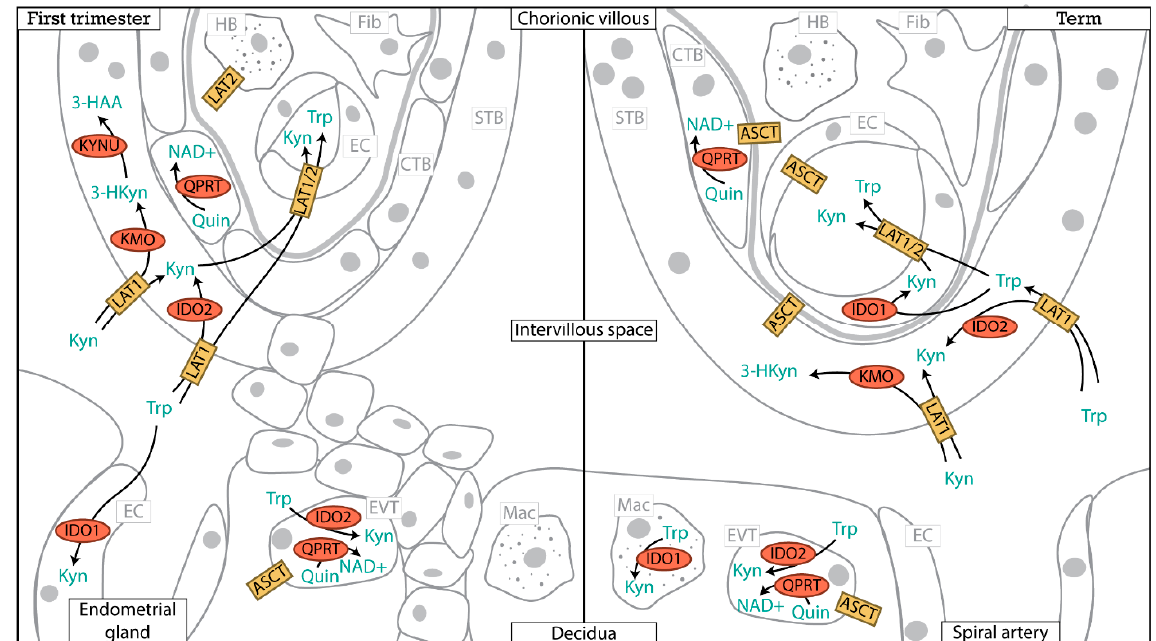
Figure 4. Illustration of kynurenine pathway enzymes and transporters localization in the first trimester and term placenta. This figure only shows the expression of enzymes (red) and transporters (yellow) confirmed by single cell RNA sequencing and/or immunohistochemistry data. The directions and interactions are a hypothetical display of the placental kynurenine pathway. How kynurenine pathway metabolites are exchanged between these cells, and whether this is facilitated by these, or other yet unidentified transporters is currently unknown. Enzymes (red): IDO, indoleamine 2,3-dioxygenase; KYNU, kynureninase; KMO, kynurenine 3-monooxygenase; QPRT, quinolinate phosphoribosyltransferase. Potential transporters (yellow): large neutral amino acid transporter (LAT); LAT1/2 depicts both LAT1 and LAT2 can be involved. Kynurenine pathway metabolites (green): Trp, L ‐ tryptophan; Kyn, L ‐ kynurenine; 3 ‐ HKyn, 3 ‐ hy ‐ droxykynurenine; 3 ‐ HAA, 3 ‐ hydroxyanthranilic acid; Quin, quinolinic acid; NAD + , nicotinamide adenine dinucleotide. Placental cell types in grey: CTB, cytotrophoblast; EC, endothelial cell; EVT, extravillous trophoblast; Fib, fibroblast; HB, Hofbauer cell; Mac, macrophage; STB, syncytiotrophoblast.